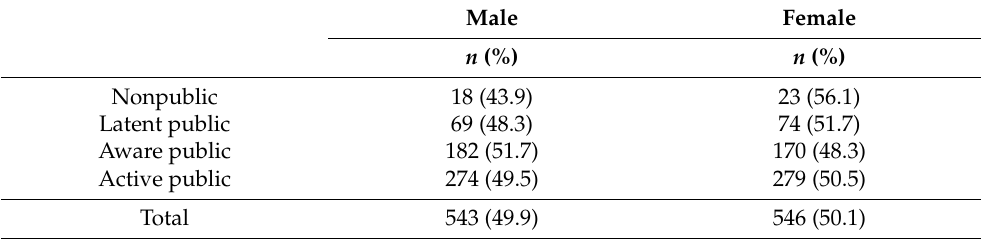
Table 3. Four types of publics and gender in China.